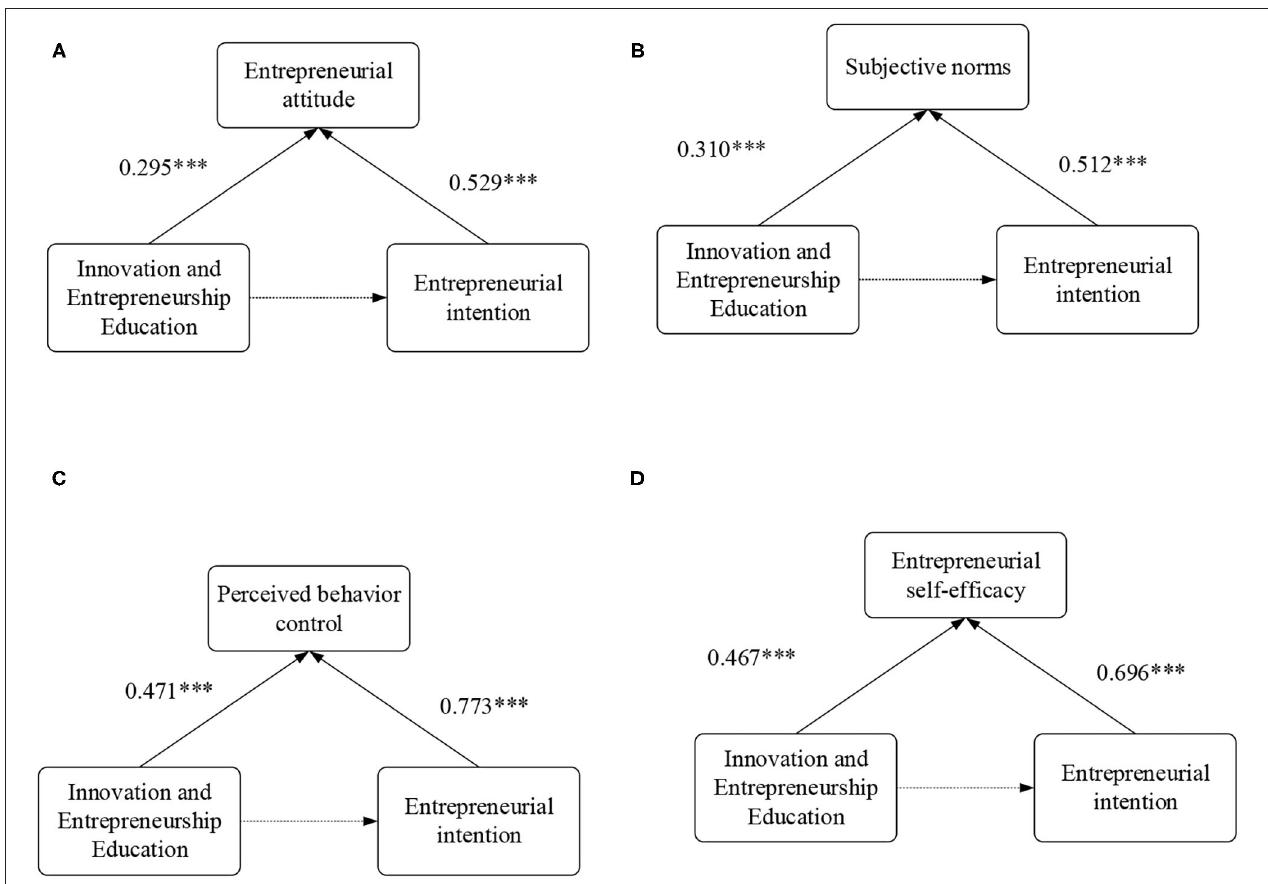
FIGURE 7 | Path analysis of the mediating effect. Figure (A) shows the path analysis of entrepreneurial attitude; Figure (B) shows the path analysis of main norms; Figure (C) shows the path analysis of the perceived behavior control; Figure (D) shows the path analysis of entrepreneurial self-efficacy. *** indicates correlation at a significance level of 0.001.